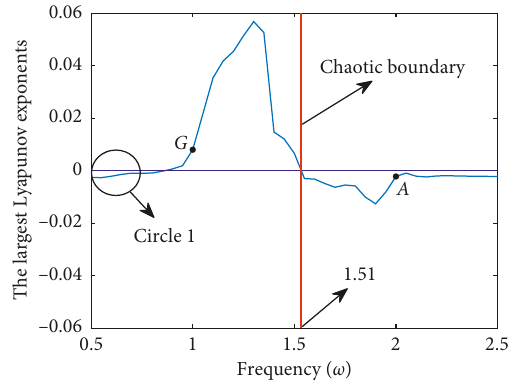
Figure 5: The largest Lyapunov exponents ( F � 1N).